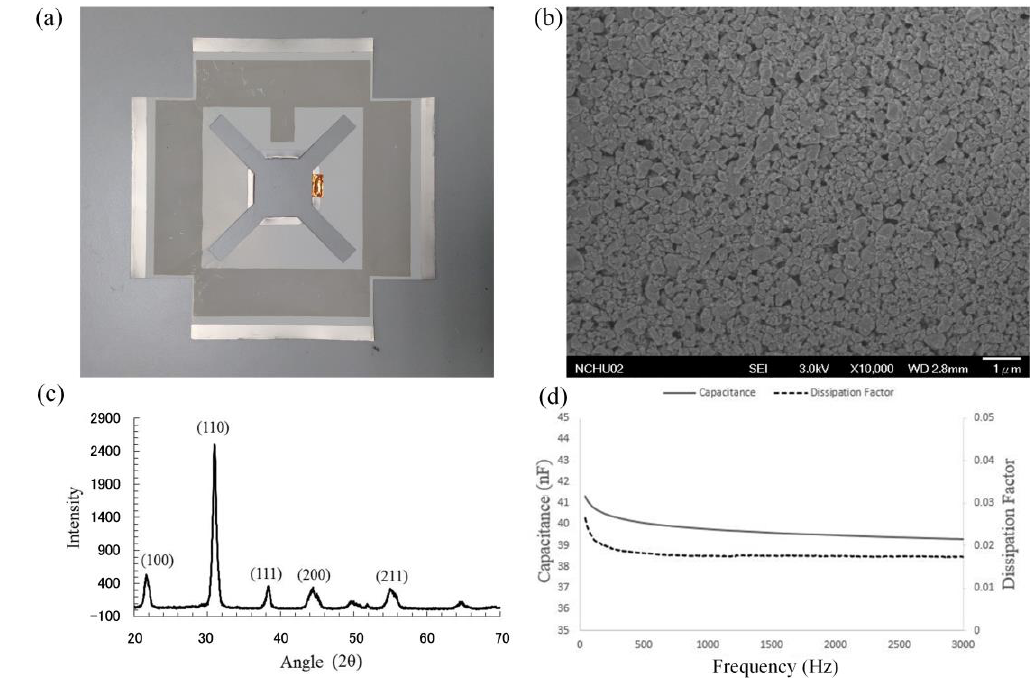
Figure 5. The result of the flexible piezoelectric composite film. ( a ) The four-plate structures of piezoelectric film; ( b ) SEM image; ( c ) X-ray diffraction (XRD) results; ( d ) capacitance test.